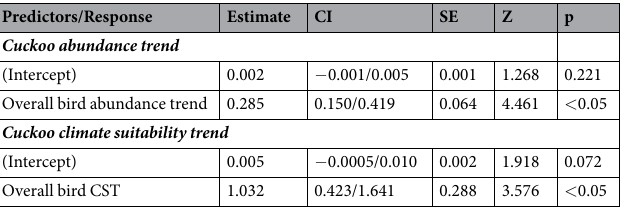
Table 2. Linear regression models based on data from European countries, accounting for cuckoo abundance trend and cuckoo climate suitability trend (CST) in relation to the same measeures for all bird populations in nineteen selected countries. The bird population trends and bird climate suitability trend in Europe were taken from Stephens et al . 14 . The full models were based on 19 countries. CI: confidence interval (lower/upper); SE: standard error. Only significant variables are shown in the table.